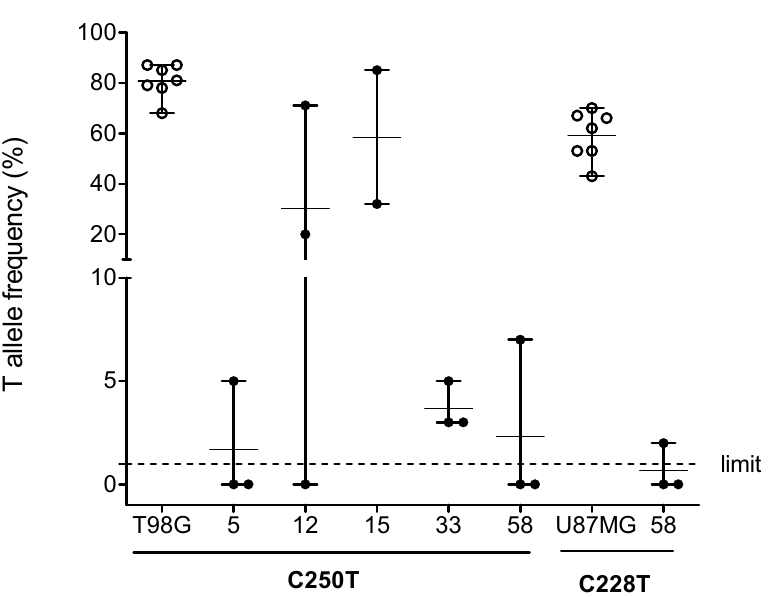
Figure 2. T allele frequencies of C250T and C228T TPMs from pNEN tissue specimens and control cell lines. Numbers indicate IDs of 5 pNEN patients identified with T allele frequencies > 1% as limit for detection. T98G and U87MG control cell lines with known TPM status. Filled dots represent, for each patient, the results of pyrosequencing replicates of DNA isolated from adjacent FFPE tumor tissue slices. Open dots represent replicates of control cell lines. Error bars represent mean with range.